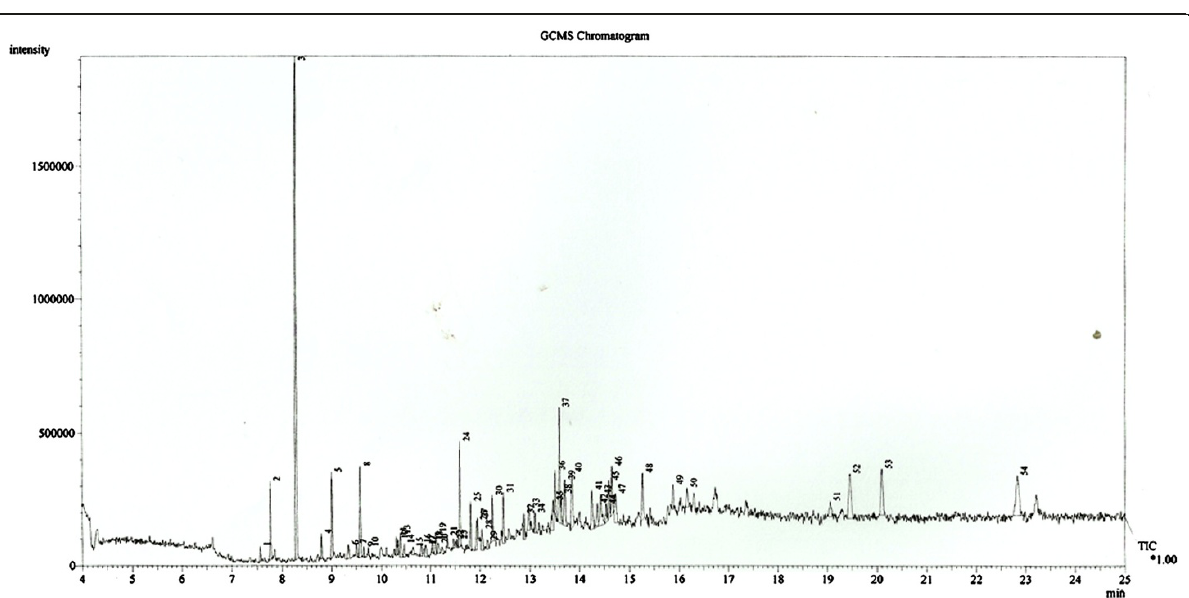
Figure 1 Major chemical constituents present in the aqueous extract of Bixa orellana